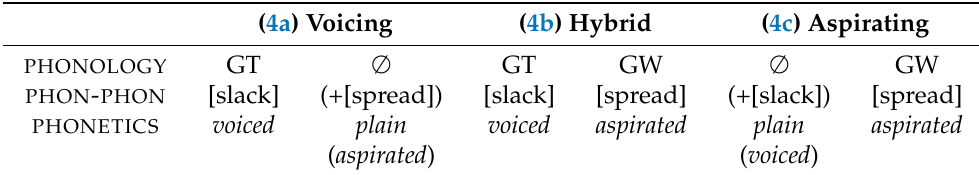
Table 3. Potential integrated representations and their